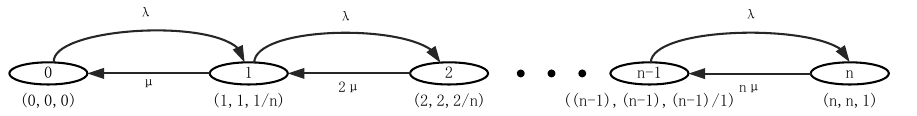
Figure 6. Service-independent state transition diagram for enhanced channel hopping mechanism in coexisting